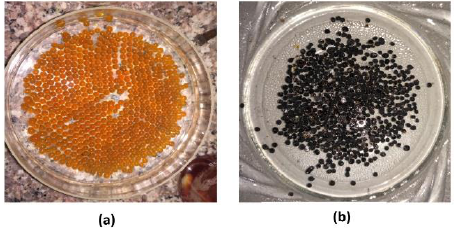
Figure 1. Photographs of Fe – CTB ( a ) before and ( b ) after drying.